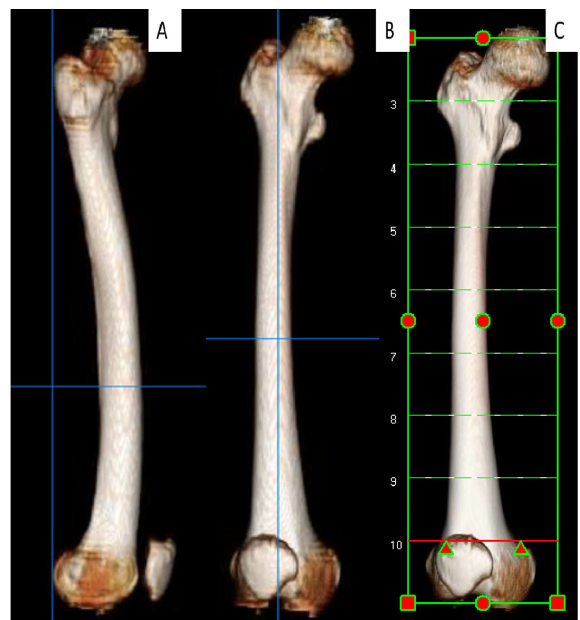
Figure 1. (A) Lateral view of the femur; both condyles are overlapped and a vertical line is tangential to the posterior condylar line and most posterior point of the greater trochanter, (B) anteroposterior view of the femur obtained by rotation of the lateral view 90 (cid:3) , (C) levels of the CT cuts starting at the widest intercondylar diameter and spaced at 5 cm